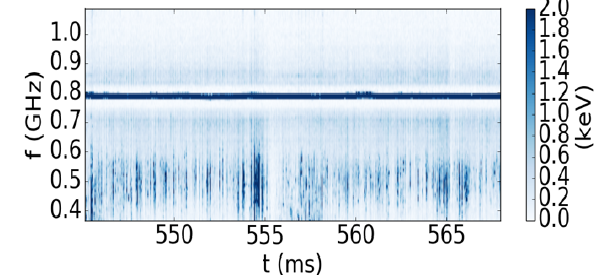
Fig. 10. Electron temperature profiles at different times during the Type 2 emissions of shot #40753, as reconstructed by the Michelson Interferometer.